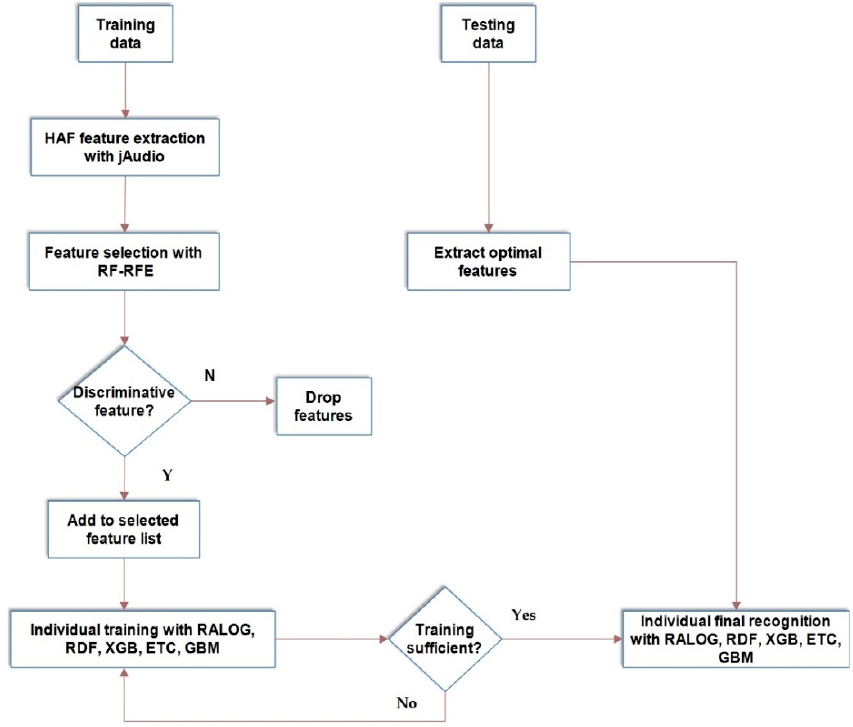
Figure 6. Di ff erent configurations of valence recognition experiments derived from [46]. Figure 6. Different configurations of valence recognition experiments derived from [46].